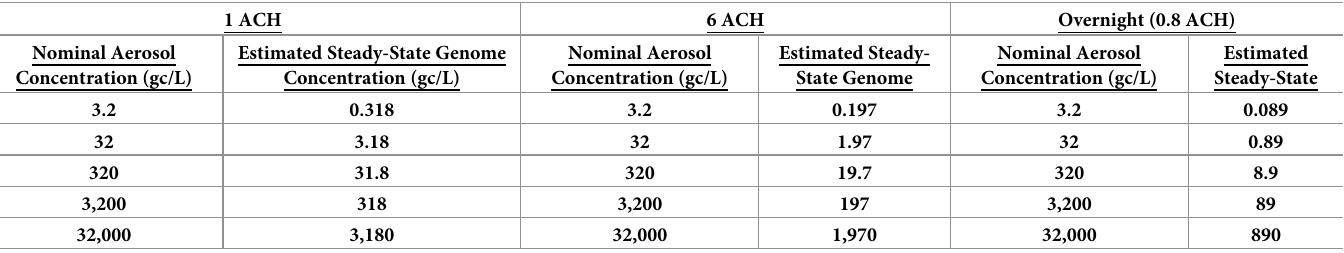
Table 2. Estimated steady-state aerosol